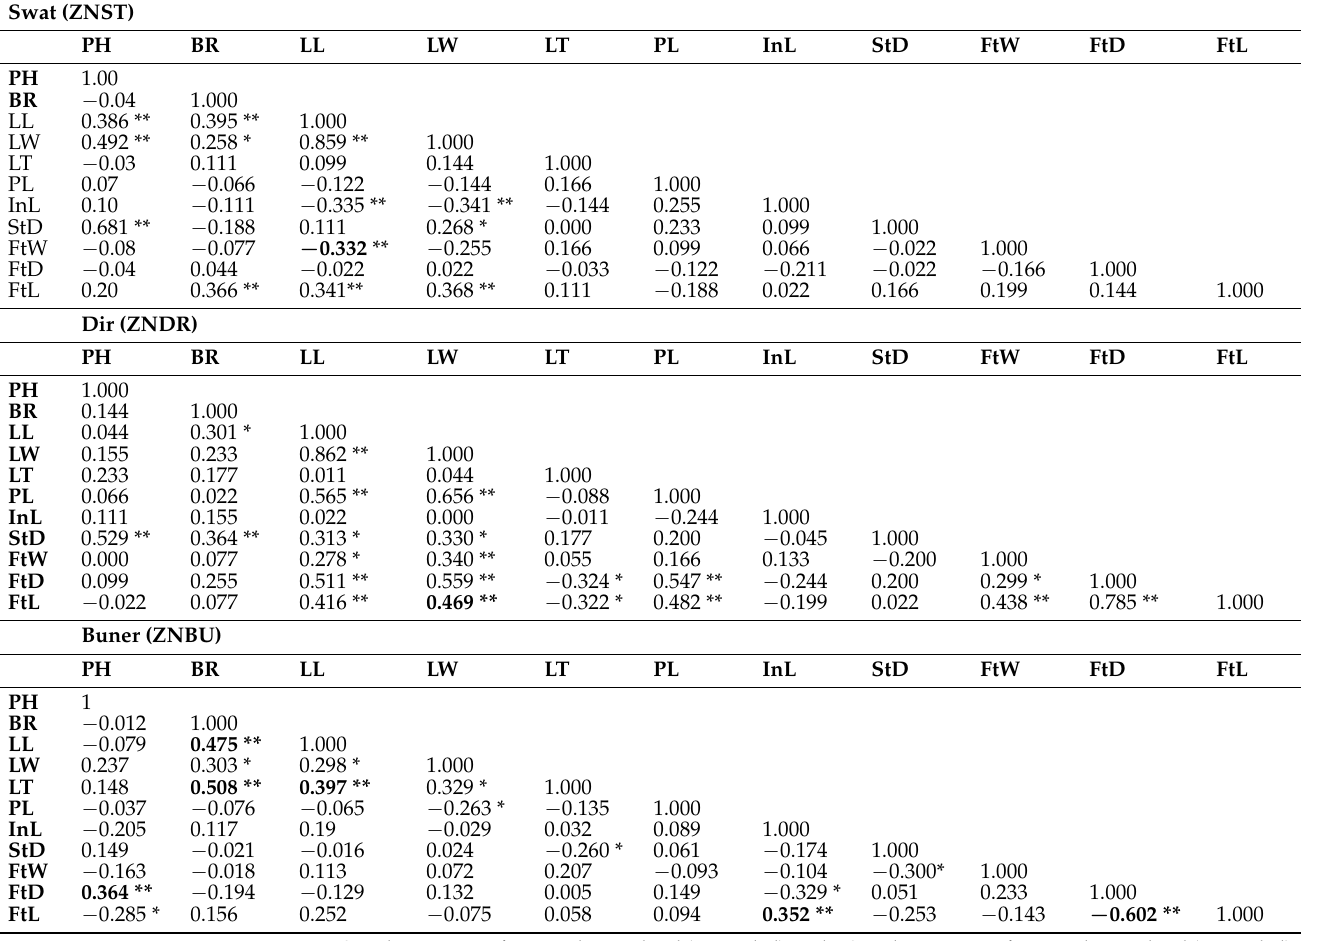
Table 3. The correlation coefficient among Z. nummularia genotypes collected from different regions of KP,